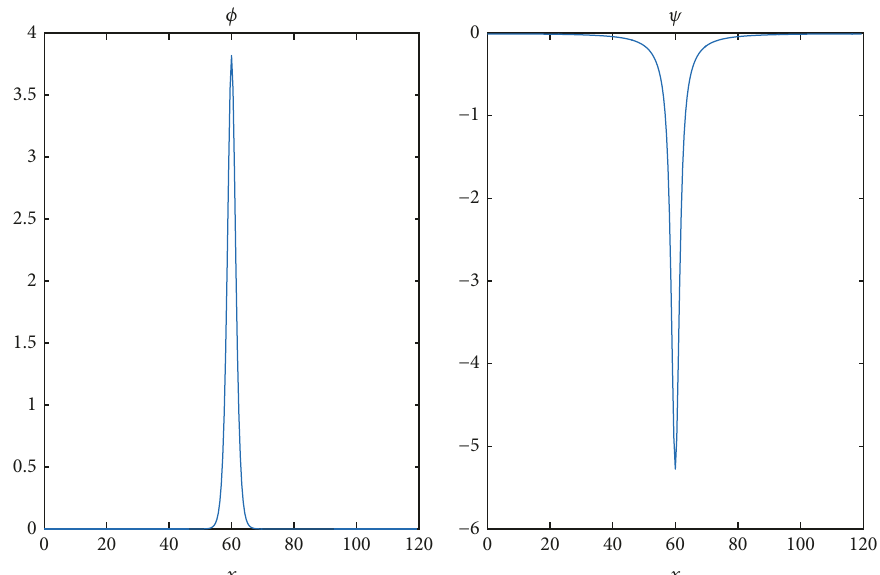
Figure 9: Approximations of the functions 𝜙, 𝜓 in the solitary wave solution (39) with 6 Newton’s iterations. The model’s parameters are 𝛼 = 𝛽 = 0.4 , 𝛾 = −1 , 𝑤 = 1.5 , and wave speed 𝑐 = 0.5 .